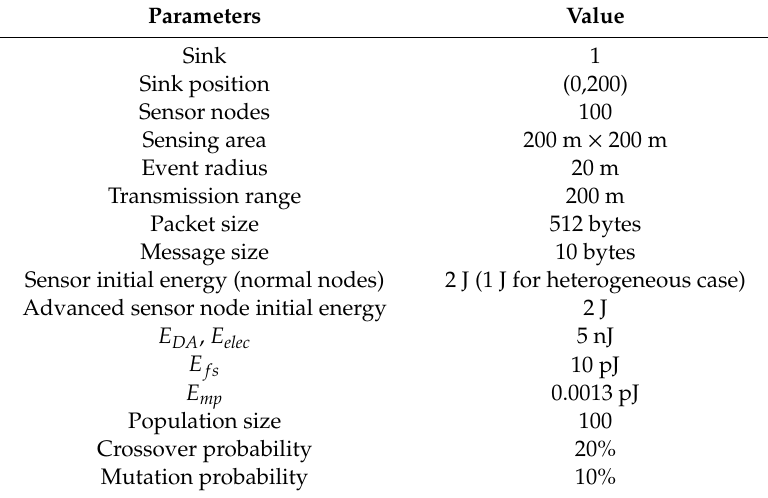
Table 2. Experimental